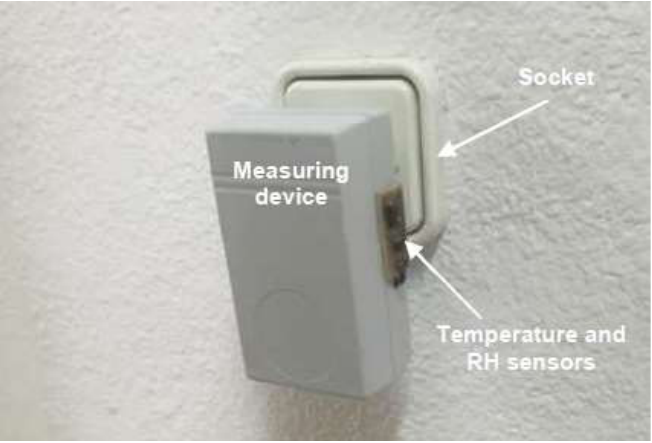
Figure 5. Measuring device installed in a socket outlet of the house.